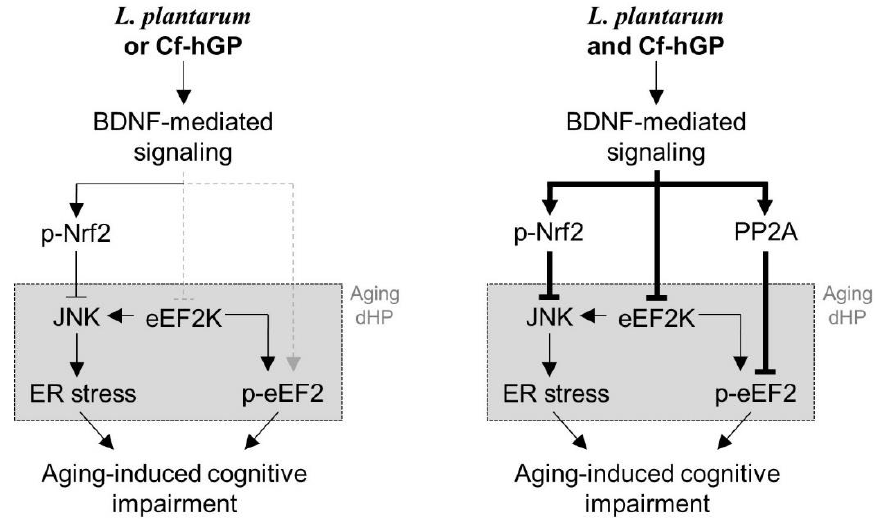
Figure 6. Scheme of a proposed mechanism of underlying effects of Cf-hGP on L. plantarum -induced cognitive improvement in aged rats. Chronic administration of Cf-hGP with L. plantarum synergistically attenuated cognitive impairment in aged rats through BDNF-mediated control of Nrf2 and eEF2 signaling in the dorsal hippocampus. Cf-hGP, Capsosiphon fulvescens glycoprotein; LP, Lactobacillus plantarum ; dHP, dorsal hippocampus; ER, endoplasmic reticulum.